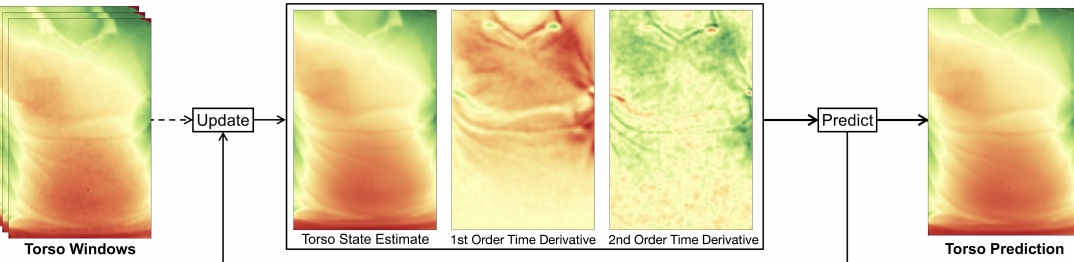
Figure 4. Our approach builds an adaptive model for the user’s torso appearance. From depth input frames, torso windows are selected over time that, after occlusion recovery, update the model consisting of a torso state estimate, its first order time derivative, and its second order time derivative. From these, the model can build a torso prediction for the next input